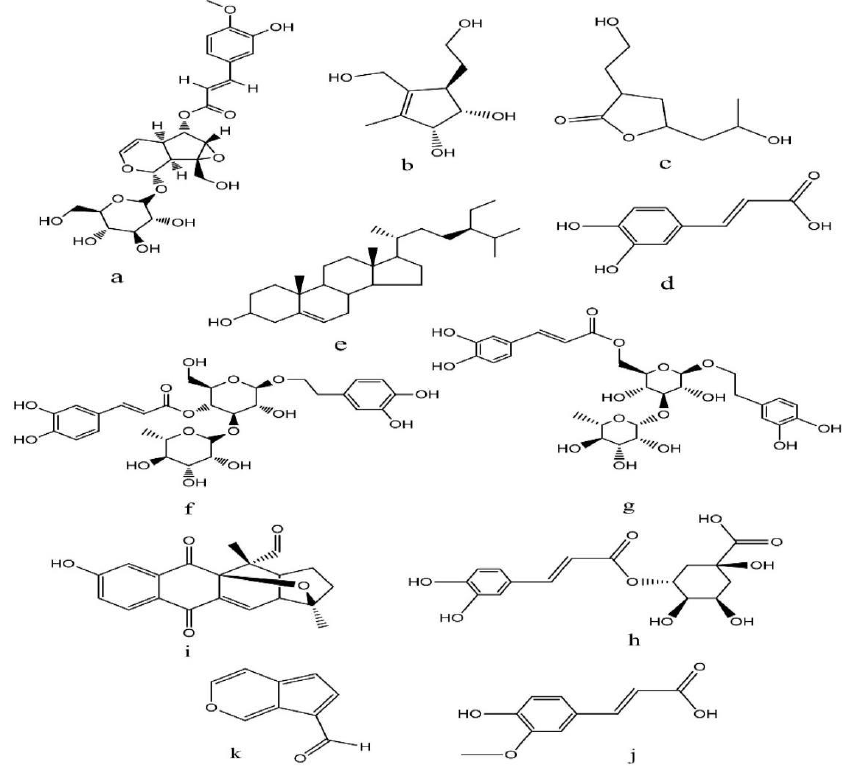
Figure 9. Structure of the phytochemicals identified by LC-MSMS in crude methanolic extracts of mature fruits (K m ) of K. pinnata in negative ion mode (TIC 2): ( a ) minecoside, ( b ) 7-hydroxy-10-deoxyeucommiol, ( c ) 3-(2-hydroxyethyl)-5-(2-hydroxypropyl)-4,5-dihydrofuran-2(3H)-one, ( d ) coffeic acid, ( e ) sitosterol, ( f ) verbascoside, ( g ) isoverbascoside, ( h ) chlorogenic acid, ( i ) isopinnatal, ( j ) ferulic acid and ( k )